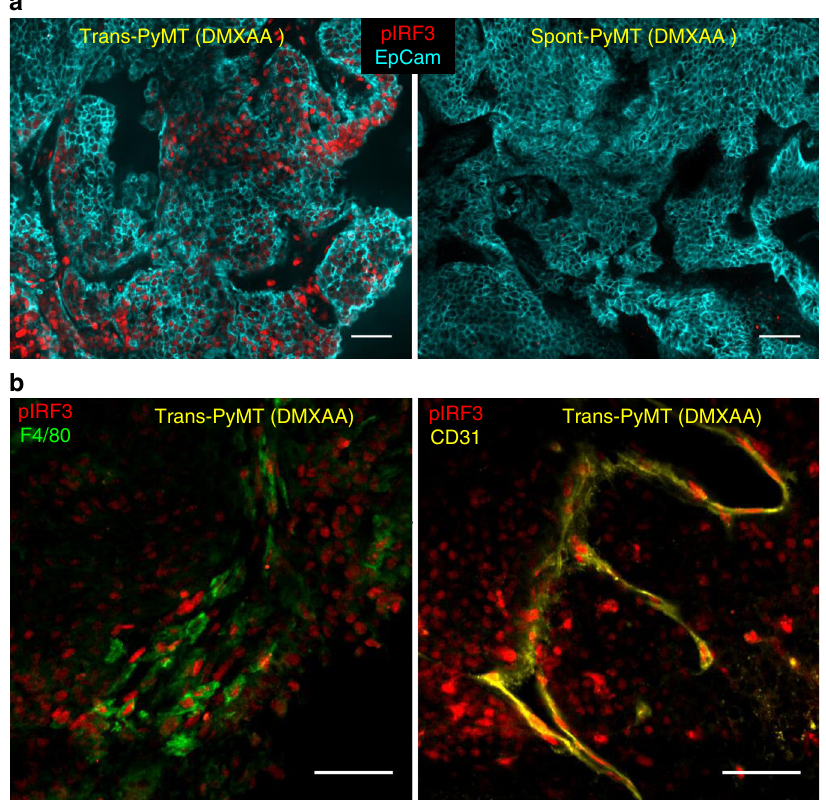
Fig. 4 Absence of IRF3 phosphorylation in Spont-PyMT tumors after DMXAA injection. a Spont-PyMT mice and Trans-PyMT mice received one i.p. injection of DMXAA. Three hours later, tumors were collected and tumors slices were stained with anti-EpCAM (blue) and anti-pIRF3 (red) mAbs. Representative images from Trans-PyMT tumors (left) and Spont-PyMT tumors (right) are shown. b In Trans-PyMT tumors, some pIRF3 + cells (red) are myeloid (F4/80 + , green), or endothelial cells (CD31 + , yellow). Scale bars = 50 µ m. The data are representative of three Spont-PyMT and fi ve Trans-PyMT mice, from fi ve independent